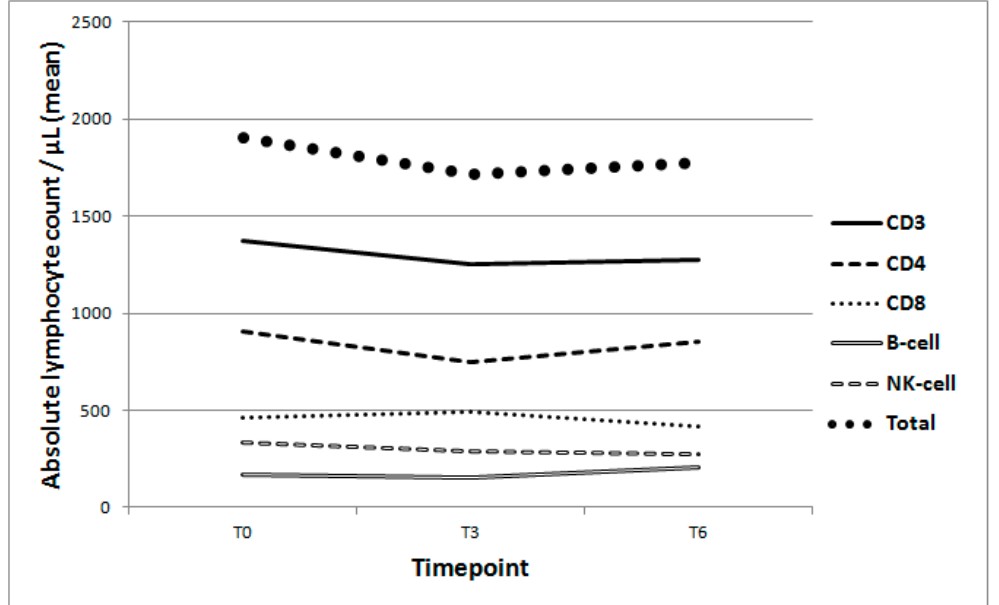
Figure A2. Comparison of mean absolute lymphocyte counts per μ L at each timepoint (T0, T3, T6) in participants for whom full data were available ( n = 9). CD3 p = 0.569 (Friedman test). CD4 p = 0.6801 (Repeated measures ANOVA). CD8 p = 0.6854 (Friedman test). B-Cell p = 0.8716 (Repeated measures ANOVA). NK-Cell p = 0.898 (Ordinary ANOVA). Total lymphocytes p = 0.9712 (Friedman test).